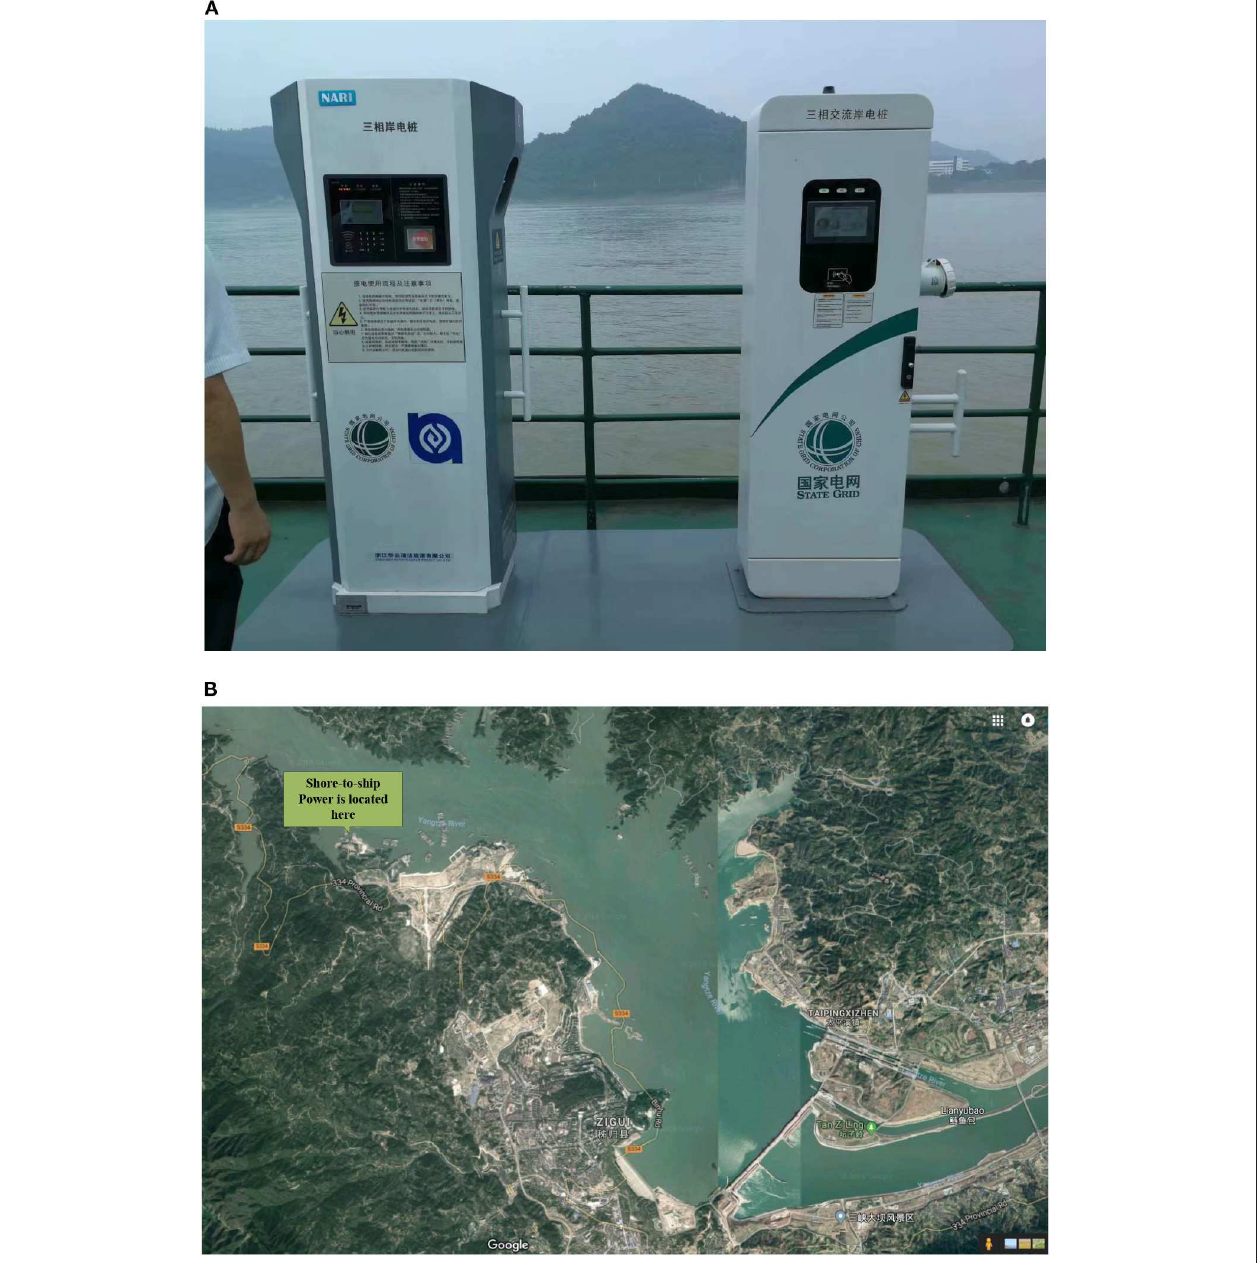
FIGURE 1 | Shore-to-ship power charging piles (China State Grid Corporation) and a map of their location beside the Yangtze River. (A) Shore-to-ship power charging piles set up by China State Grid Corporation with no cable lifting device and connection system. (B) The shore-to-ship power charging piles are located on the upper left bank of the Yangtze River Three Gorges